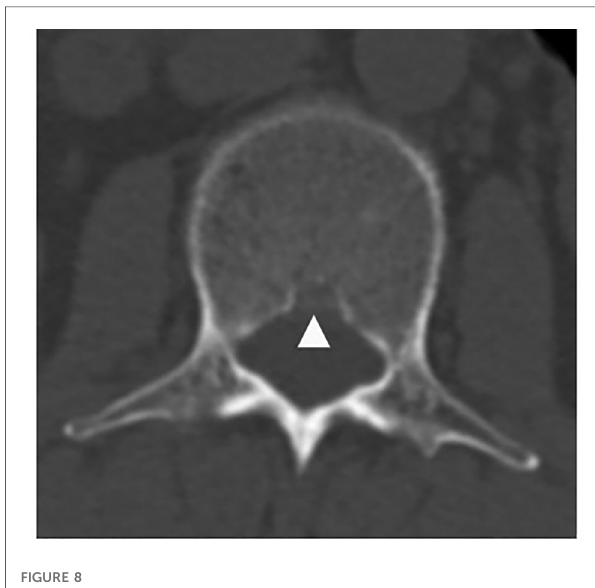
FIGURE 8 A wide BF is shown in CT scan (arrow